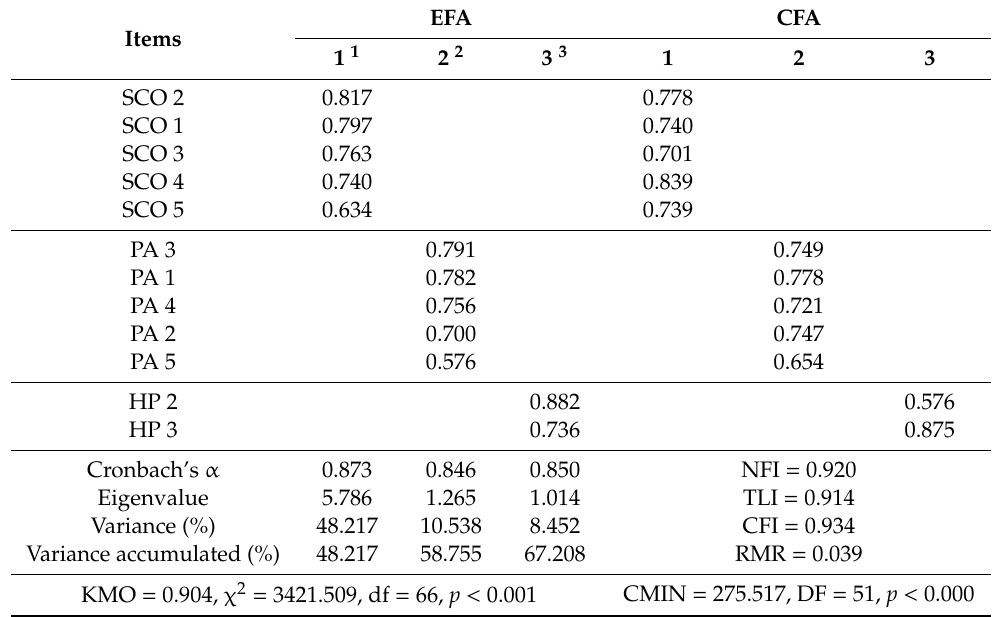
Table 1. Results of Exploratory and Confirmatory Factor Analyses (EFA, CFA) for Physical Self- Concept.